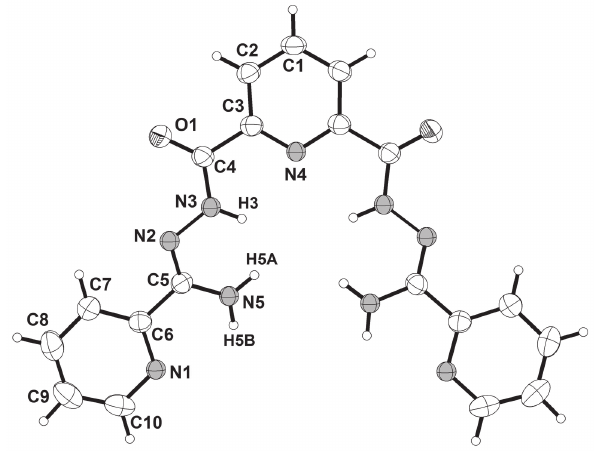
Table 1: Data collection and handling.